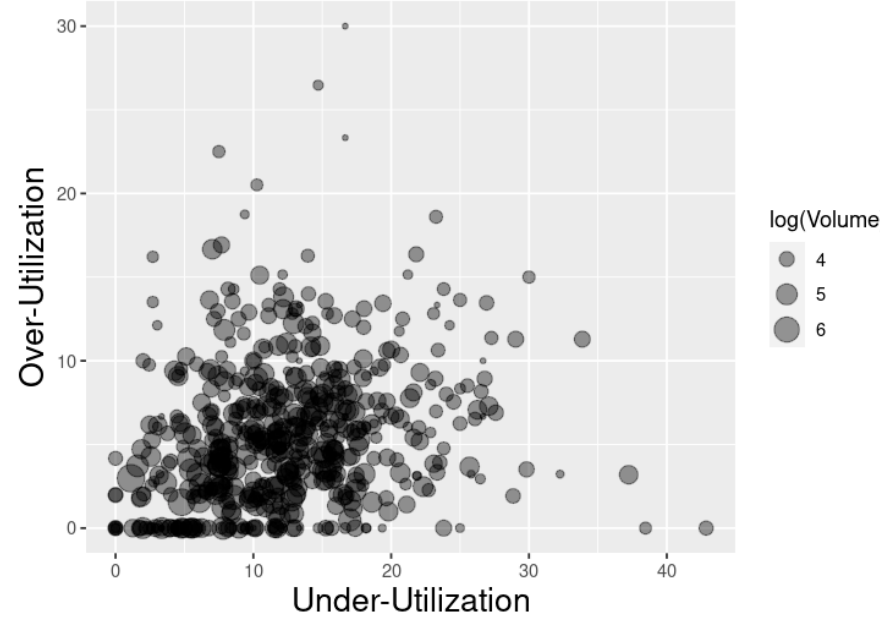
Figure 7. Bubble plot of under- and over-utilization with log(volume) representing facility size.